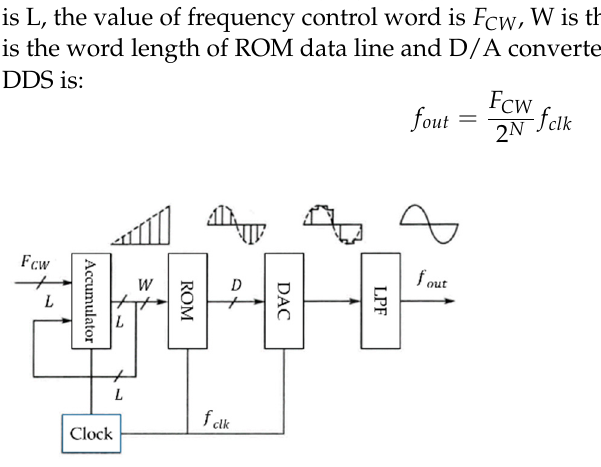
Figure 5. DDS schematic diagram.